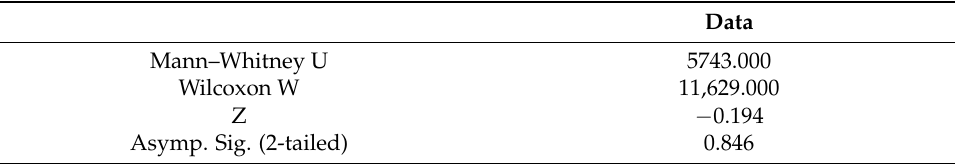
Table 6. Mann–Whitney test